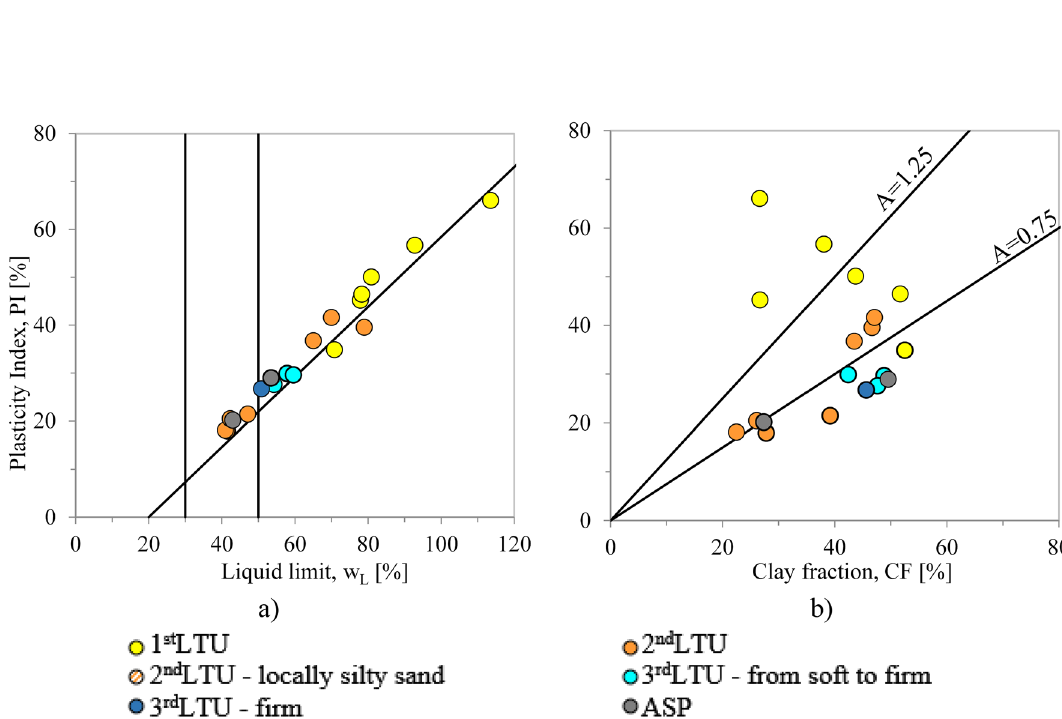
Figure 10. Casagrande’s plasticity ( a ) and Activity ( b ) charts of the samples collected within different LTUs (S1, S2, S3, S4, S6, S7 sites of section N–N ′ in Fig.